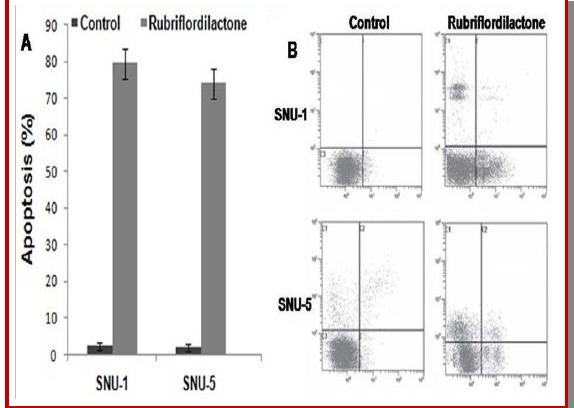
Figure 2 : Viability of the gastric cancer and non-cancer cells in acidic media. The viability of cancer cells remained un-effected in acidic media